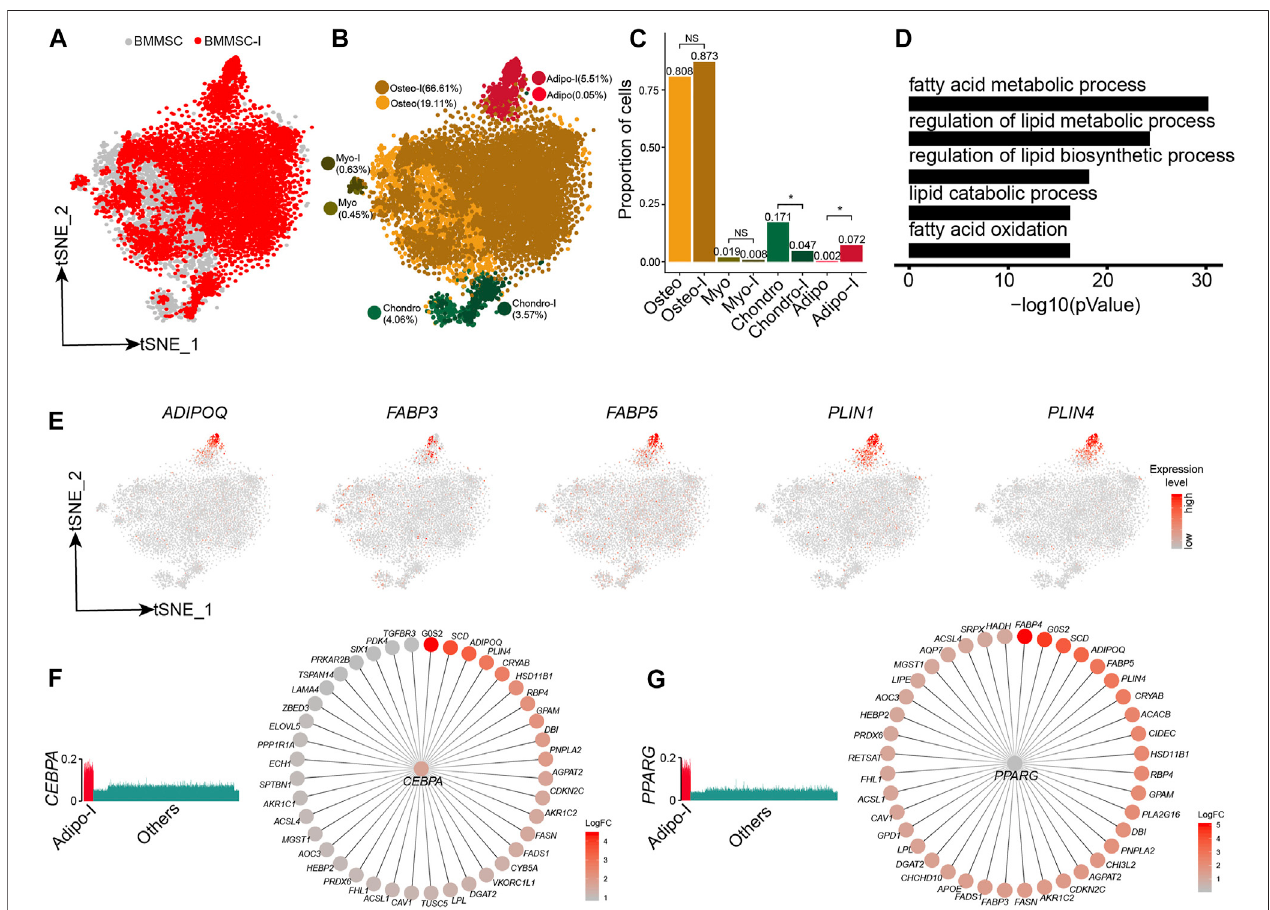
FIGURE 5 | Response heterogeneity and dynamics of MSCs to adipogenesis induction and its underlying mechanisms. (A) . t-SNE projection of MSCs pre-and post-adipogenesis induction, colored by non-induced BM-MSC (BM-MSCs) and adipogenic-induced MSCs (BMMSC-I). (B) . t-SNE projection of MSCs pre-and post- adipogenesis induction, colored by MSC subpopulations, namely chondro, osteo, adipo, myo, chondro-I, osteo-I, adipo-I, and myo-I. (C) . Fractions of MSC subpopulation in BM-MSCs and adipogenesis-induced MSCs. Fisher ’ s exact test, * p -value < 0.05. (D) . Signi fi cantly enriched GO terms in adipo-speci fi c genes. (E) . Expression of adipogenic lineage-speci fi c genes on t-SNE projection of MSCs. (F) . Expression of CEBPA in single cells (left panel) , CEBPA and its target genes, with each target gene colored by log fold change between adipogenesis-induced adipo and pre-induced adipo (right panel) . (G) . Expression of PPARG in single